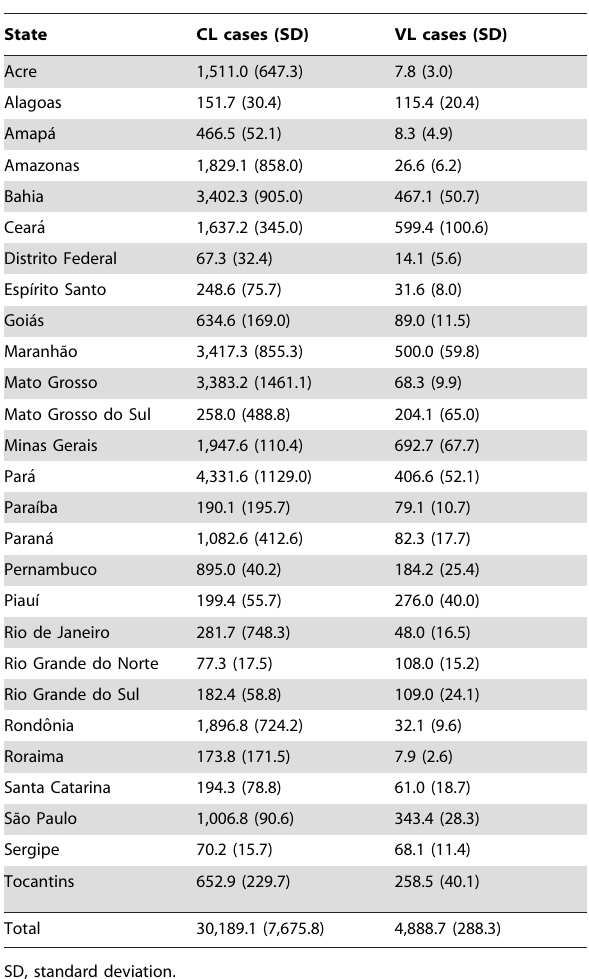
Table 5. Country and state predicted cases of cutaneous leishmaniasis (CL) and visceral leishmaniasis (VL) in Brazil in